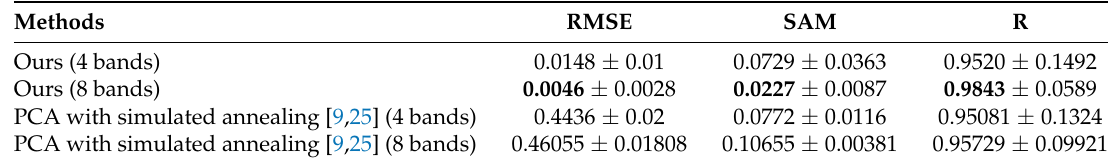
Table 6. Performance of MS bands learned using G-LiHT data on AVIRIS imagery.